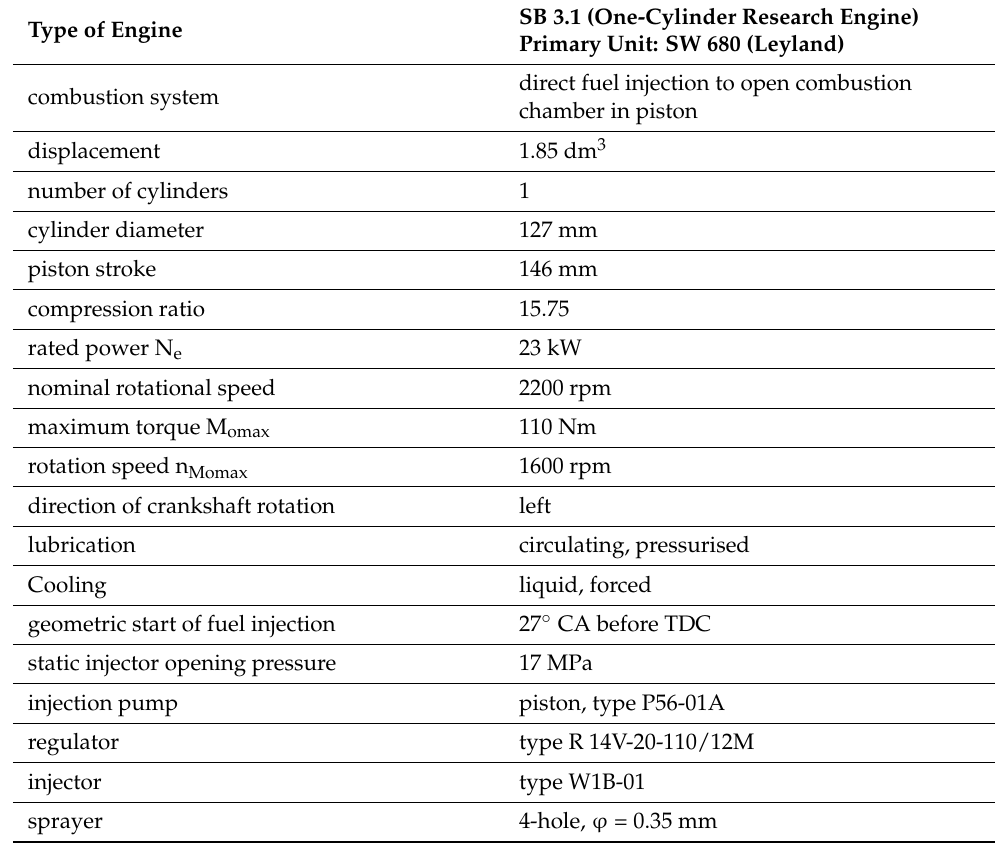
Table 1. Technical specifications of